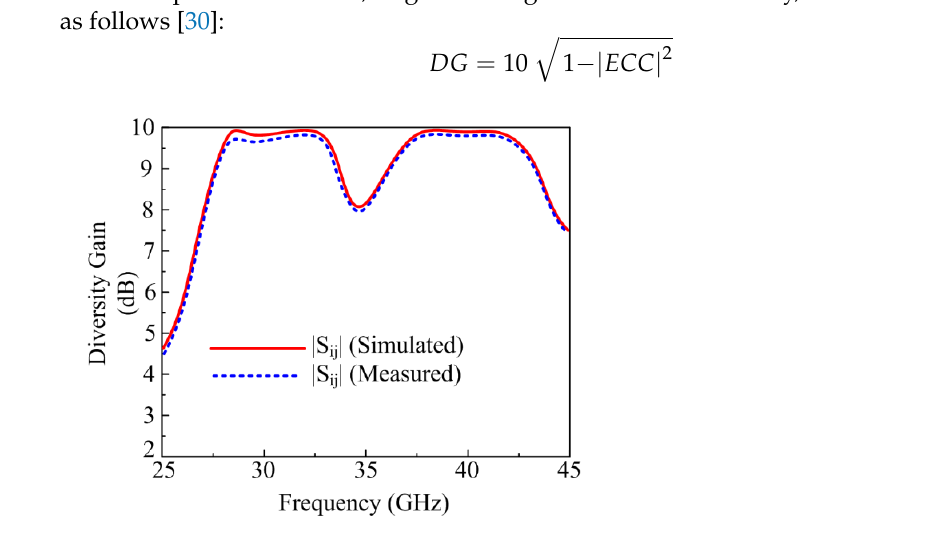
Figure 14. Diversity Gain (DG) of the proposed parasitic element-loaded dual-band MIMO an- tenna.